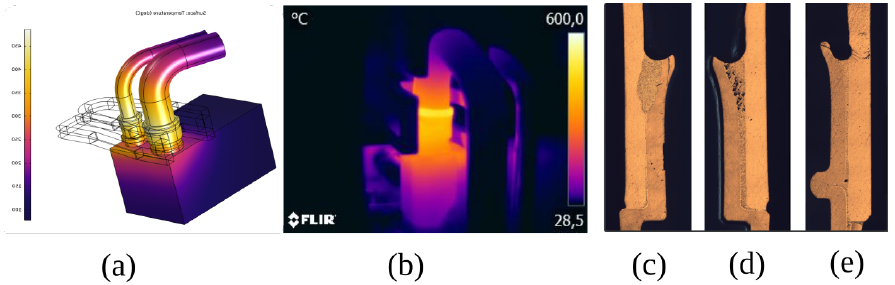
Figure 2. Coupled FEM model ( a ) and thermal camera image ( b ) of an induction brazing process design. The other three images show the possible errors during the brazing process: ( c ) dissolution, ( d ) porosity, and ( e )